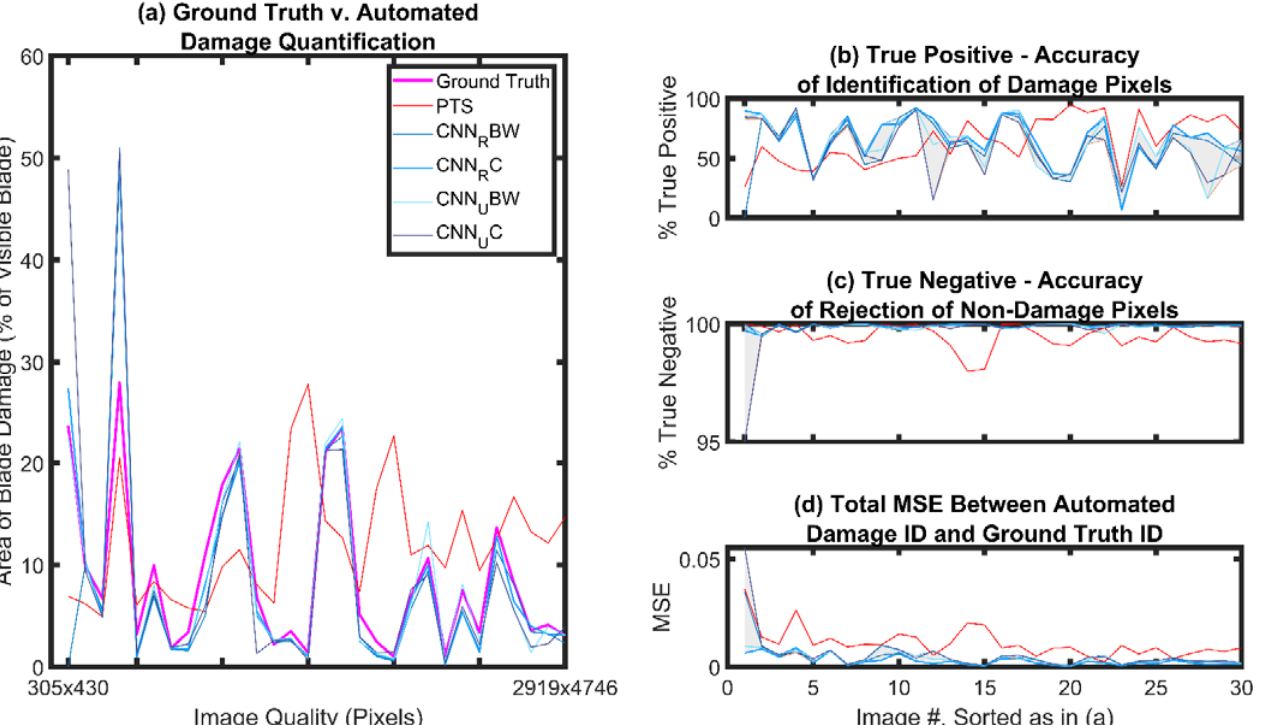
Figure 11. ( a ) Automated LEE quantification results for the unsupervised PTS module (red) and supervised CNN modules (blue) compared to subjective quantification for all damage (deep and shallow) (magenta). ( b ) Accuracy of automated identification of LEE pixels compared to subjective identification. ( c ) Accuracy of rejection of non-LEE pixels compared to subjective identification (higher accuracy denotes fewer false positives in pixels assigned to the LEE class, i.e., less noise). ( d ) Total mean square error between automated and subjective LEE pixel identi fi cation. The gray shading shows the dispersion in the CNN results (maximum and minimum CNN results for each panel, i.e. b, c, and d, are used as the boundaries for the gray shading).